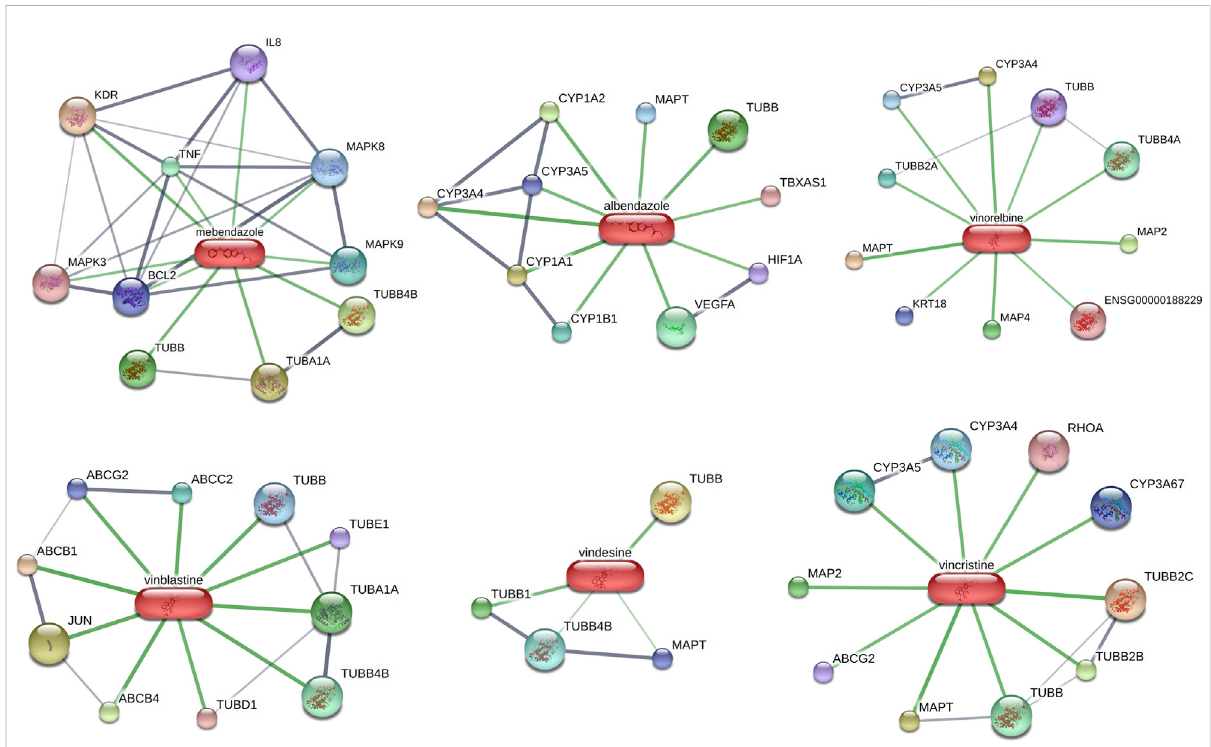
FIGURE 8 Potential targeted drugs prediction and interactions between top six drug candidates and proteins based on DEGs of nine HCC samples.